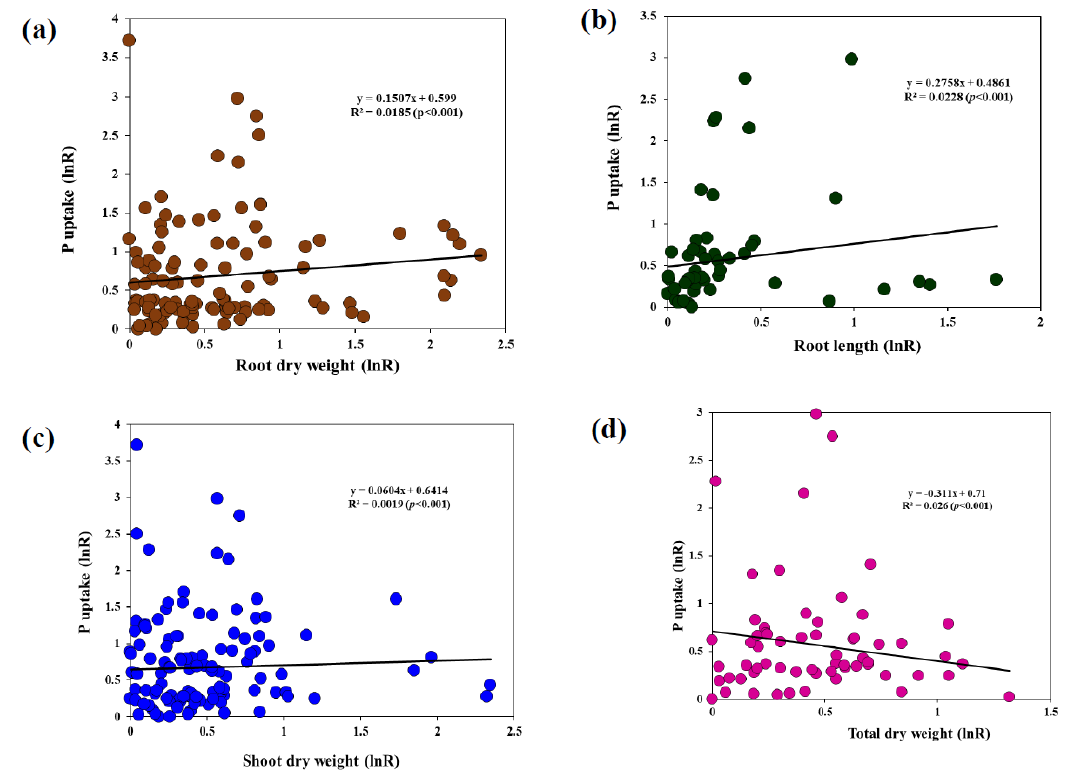
Figure 3. Correlation analysis. ( a ) P uptake vs. root dry weight; ( b ) P uptake vs. root length; ( c ) P uptake vs. shoot dry weight; ( d ) P uptake vs. total dry weight.